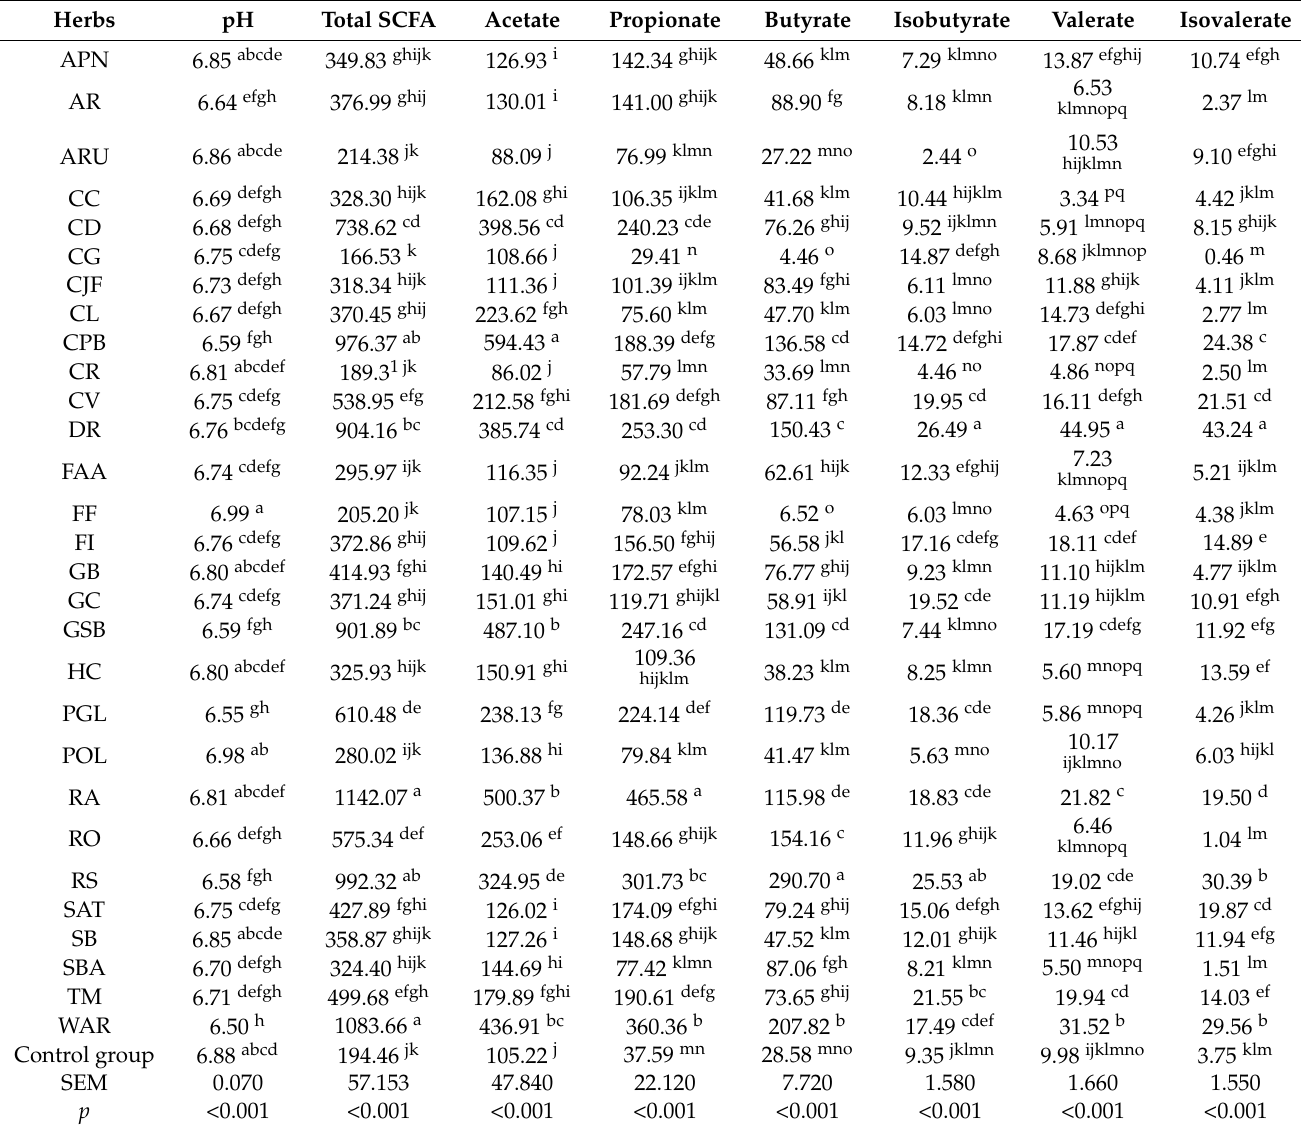
Table 7. Short-chain fatty acids (SCFAs) concentrations of 29 different Chinese herbs at 48 h of in vitro incubation ( µ mol/100